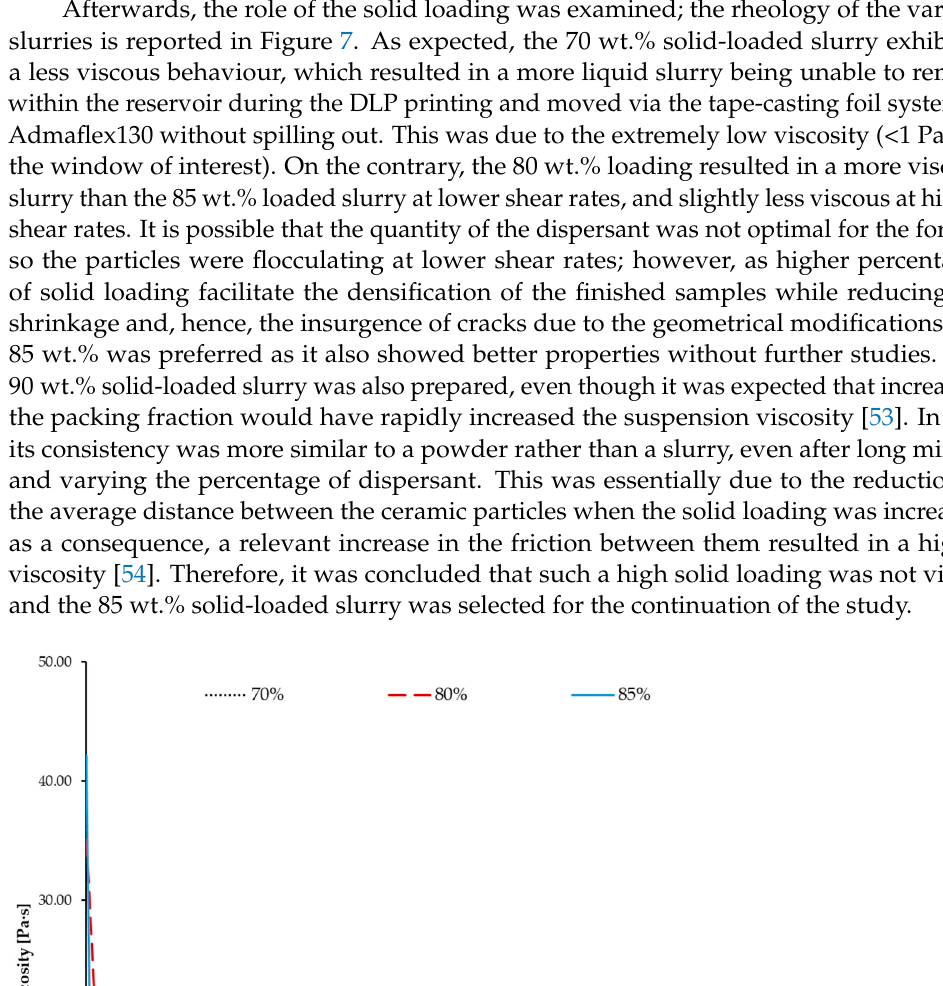
Figure 8. Cure depth values of the slurry at different exposure powers and times. The values of D p and E c can be deducted from the linear regression of the collected data and, in particular, D p = 59.018 µm and E c = 1.399 mJ/cm 2 . While the latter is compatible with a highly reactive slurry, the former describes a slurry that permits better control of lateral definition, as smaller values of D p promote higher resolution [55]. In addition, even though all the values were registered while using different exposure parameters, all the collected data points lay acceptably around the trend line obtained from the linear